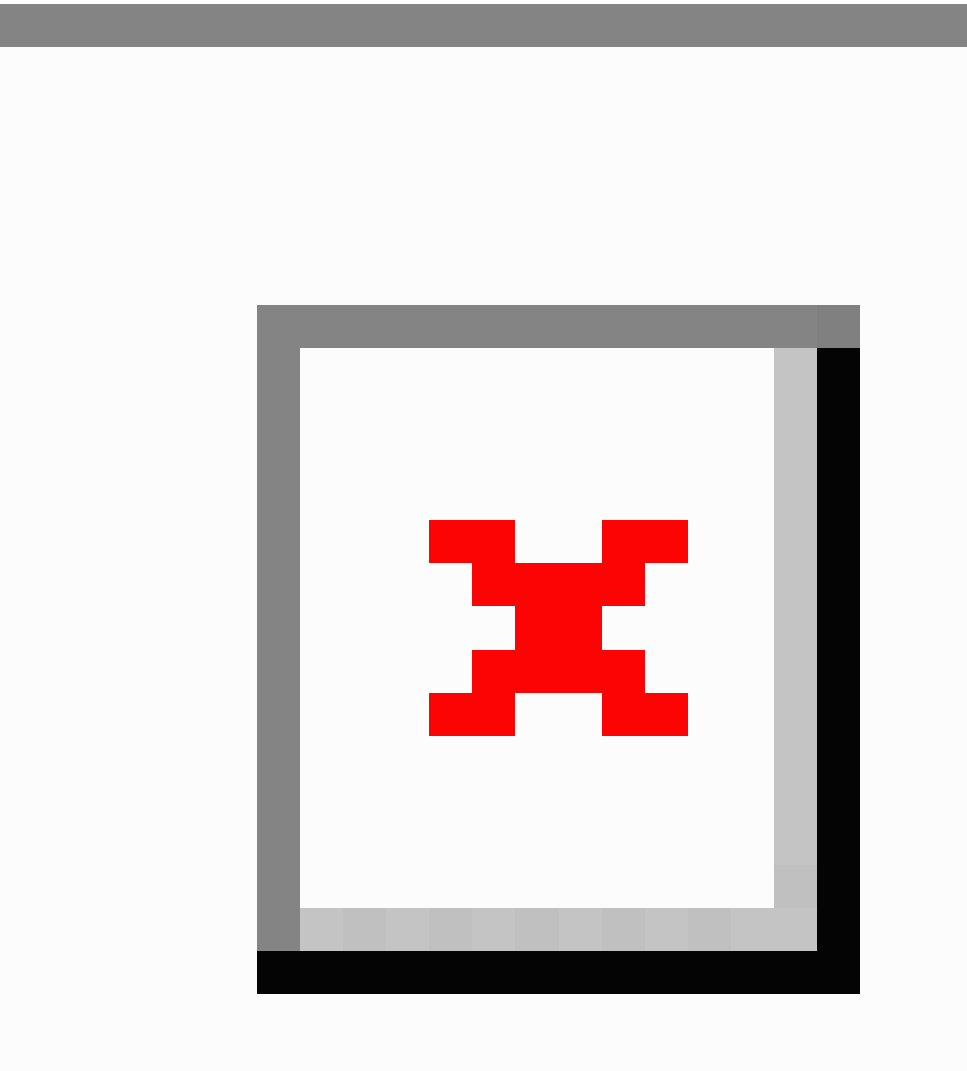
Figure 4. Swarm plot depicting the support vector machine–derived probability of being either non-rheumatoid arthritis (blue) or rheumatoid arthritis (green) for the Leiden-A data set. The dotted lines display the optimal cutoffs. Sens: sensitivity, Spec: specificity; PPV: positive predictive value; NPV: negative predictive value; Acc: accuracy; F1: F1